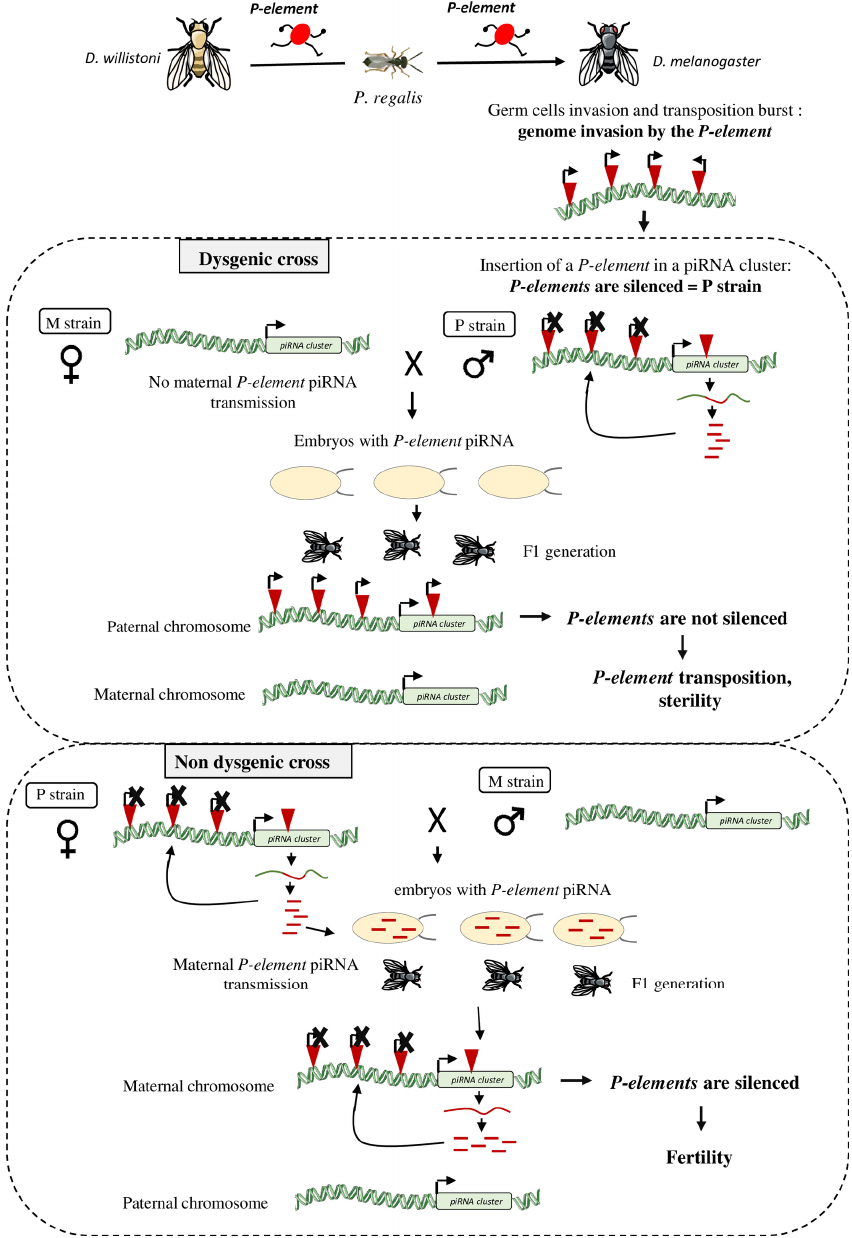
Figure 2. Host response following a TE horizontal transfer: example of the D. melanogaster genome invasion by the P-element. The P-element originally found in the D. willistoni genome has been transferred to D. melanogaster in the 1950s, possibly via the mite Proctolaelaps regalis. After germ cell invasion by the P-element , a transposition burst induced the creation of many P-element inheritable insertions. The P-element invaded the D. melanogaster genome and at one point it jumped into a piRNA cluster where piRNAs complementary to this element are produced to silence genomic P-elements (P strain). When a male with functional genomic P-elements (P strain) is crossed with a female without P-element (M strain), their offspring will be sterile ( dysgenic cross). Indeed, the M female does not transfer any P-element piRNA to the embryos. These piRNAs are require to initiate the production of P-element piRNAs by the piRNA cluster present on the paternal chromosome of the offspring. Without P-element piRNA production in the F1 progeny, genomic P-elements are not silenced, leading to sterility. In the reverse cross (P female x M males), the F1 flies are fertile ( non-dysgenic cross). Here, P-element piRNAs produced in the ovaries of the P mother are deposited in the embryos and allow the activation of the maternal P-element -containing piRNA cluster for the genomic P-element silencing.